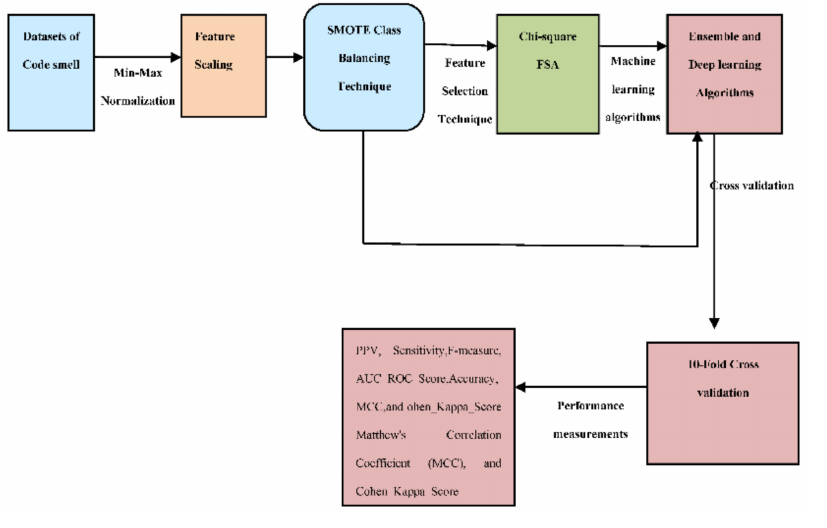
Figure 1. Proposed research scheme.